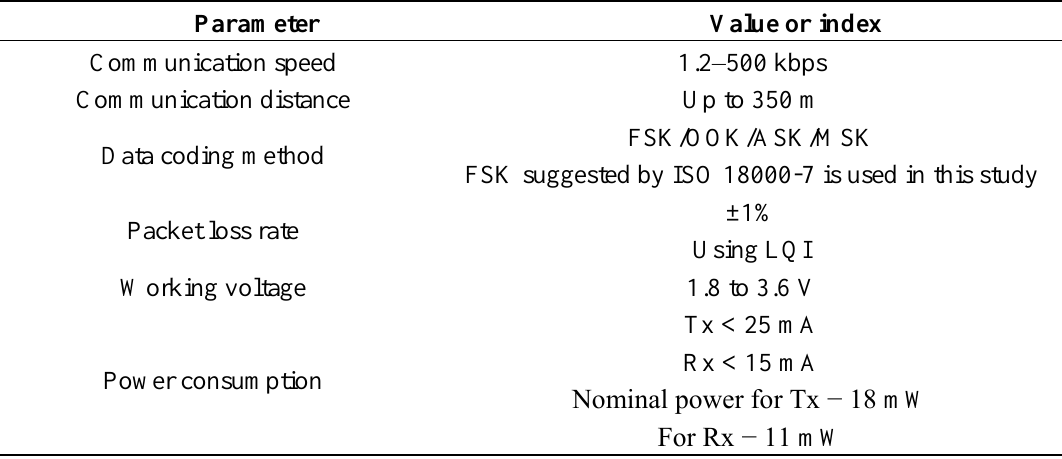
Table 2. Parameters of the wireless communication